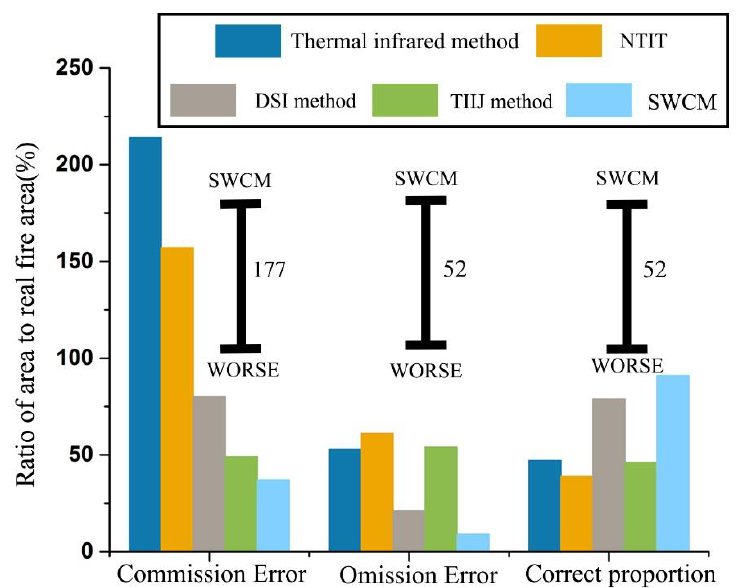
Figure 11. Coal fire detection based on different methods in the study area. The percentages on the vertical axis are the ratio of omission error, commission error, and correctly identified coal fire areas to the real coal fire areas.